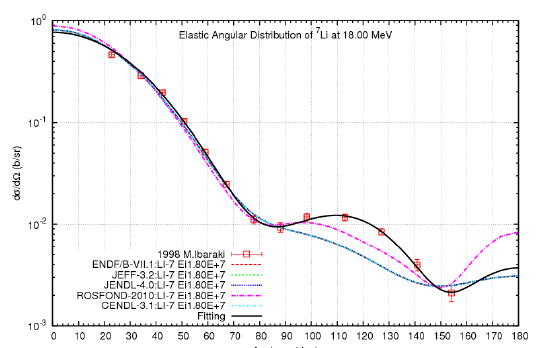
Fig. 6 . The updated angular distribution of the n+ 7 Li elastic scattering reactions at E n = 18 MeV. The solid lines for the Legendre fittings, and the dots are experiment data in EXFOR [13].